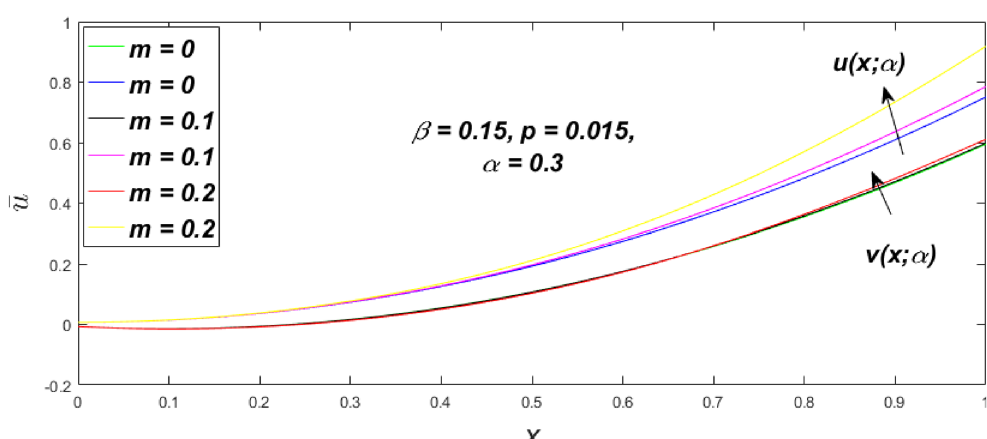
Figure 33. Fuzzy velocity for the impact of